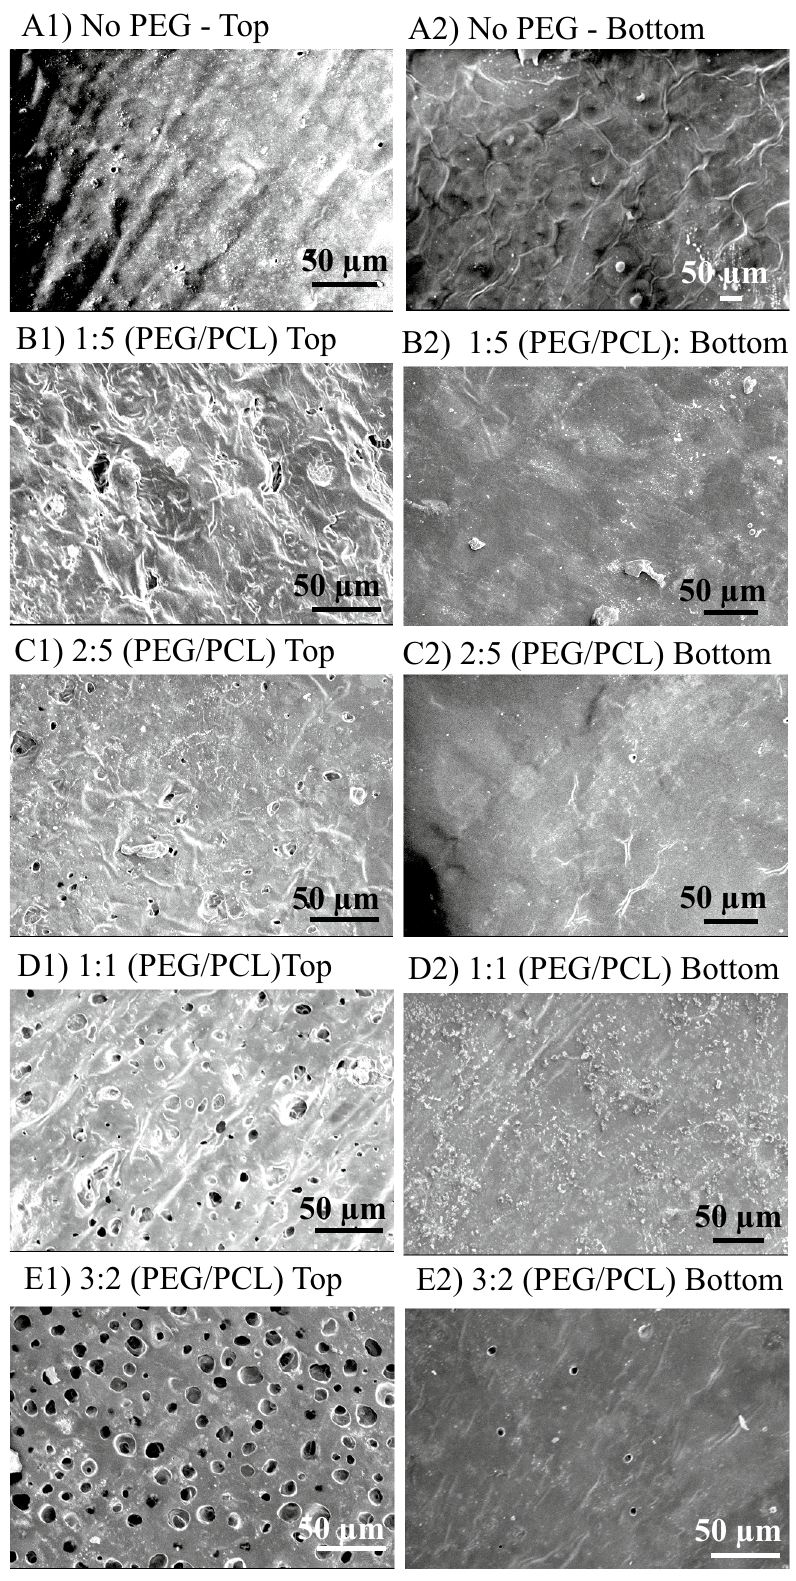
Figure 8. SEM images of both sides (top and bottom) of PCL membranes prepared by addition of different amount of PEG. PEG/PCL w/w ratio is 0 ( A ), 1:5 ( B ), 2:5 ( C ), 1:1 ( D ) and 3:2 ( E ). Only the ratio of 3:2 PEG/ PCL formed pores in both sides, which is selected to be used as the Film in the knee plug. The average size of the formed pores in the Film is 10